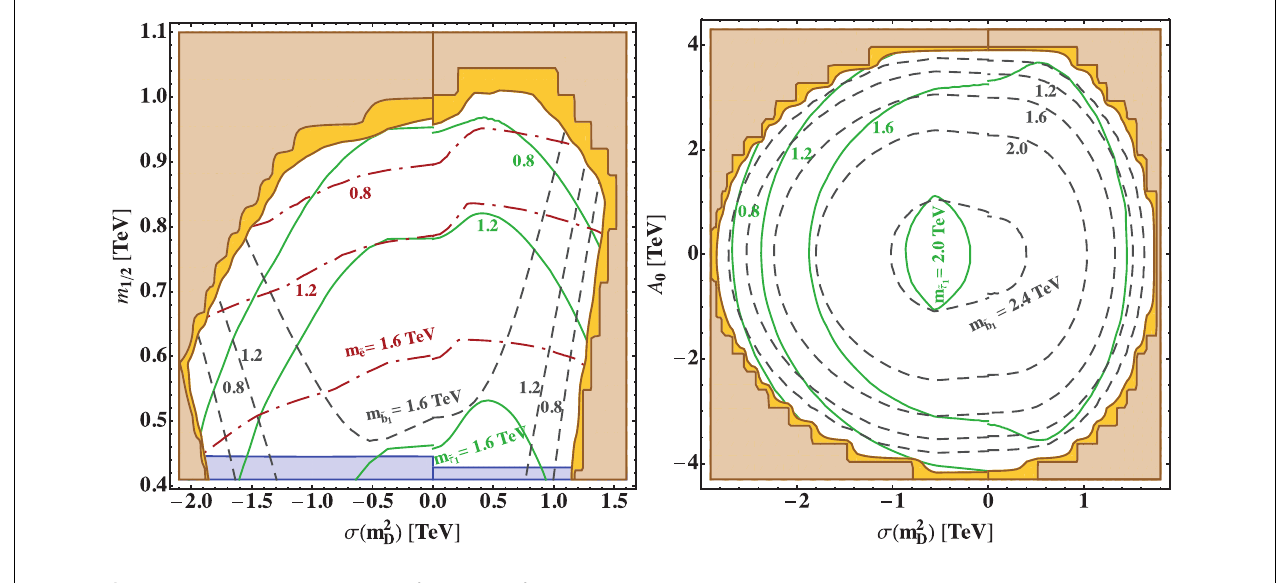
FIGURE 6 | Mass of the lightest stau ˜ τ 1 (solid green), sbottom Equation (22) . The colored areas are excluded or disfavored ˜ b ˜ e (dash-dotted red) as a because there is at least one tachyonic state (brown), the 1 (dashed gray), and selectron and m 1 / 2 (left) and of m 2 and A 0 (right). function of m 2 neutralino is not the LSP (orange), the gluino mass is below the D D The remaining parameters are respectively fixed as described in experimental limit (blue).